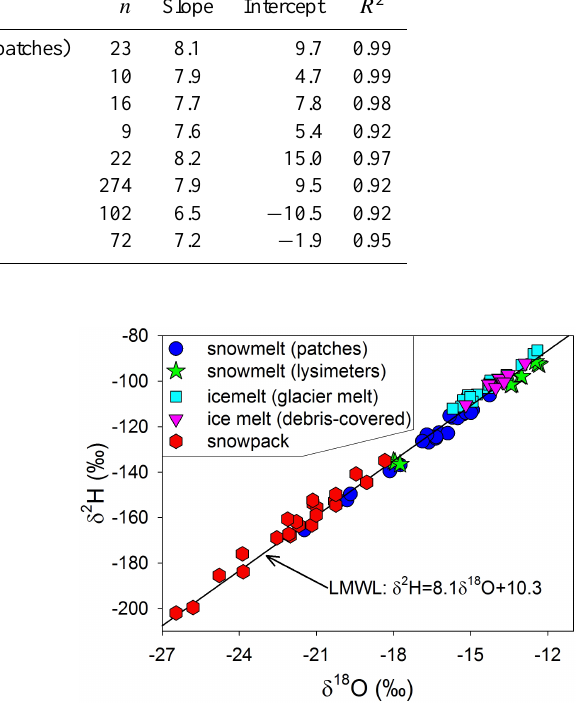
Figure 4. Relationship between δ 2 H and δ 18 O values of snowmelt, ice melt and